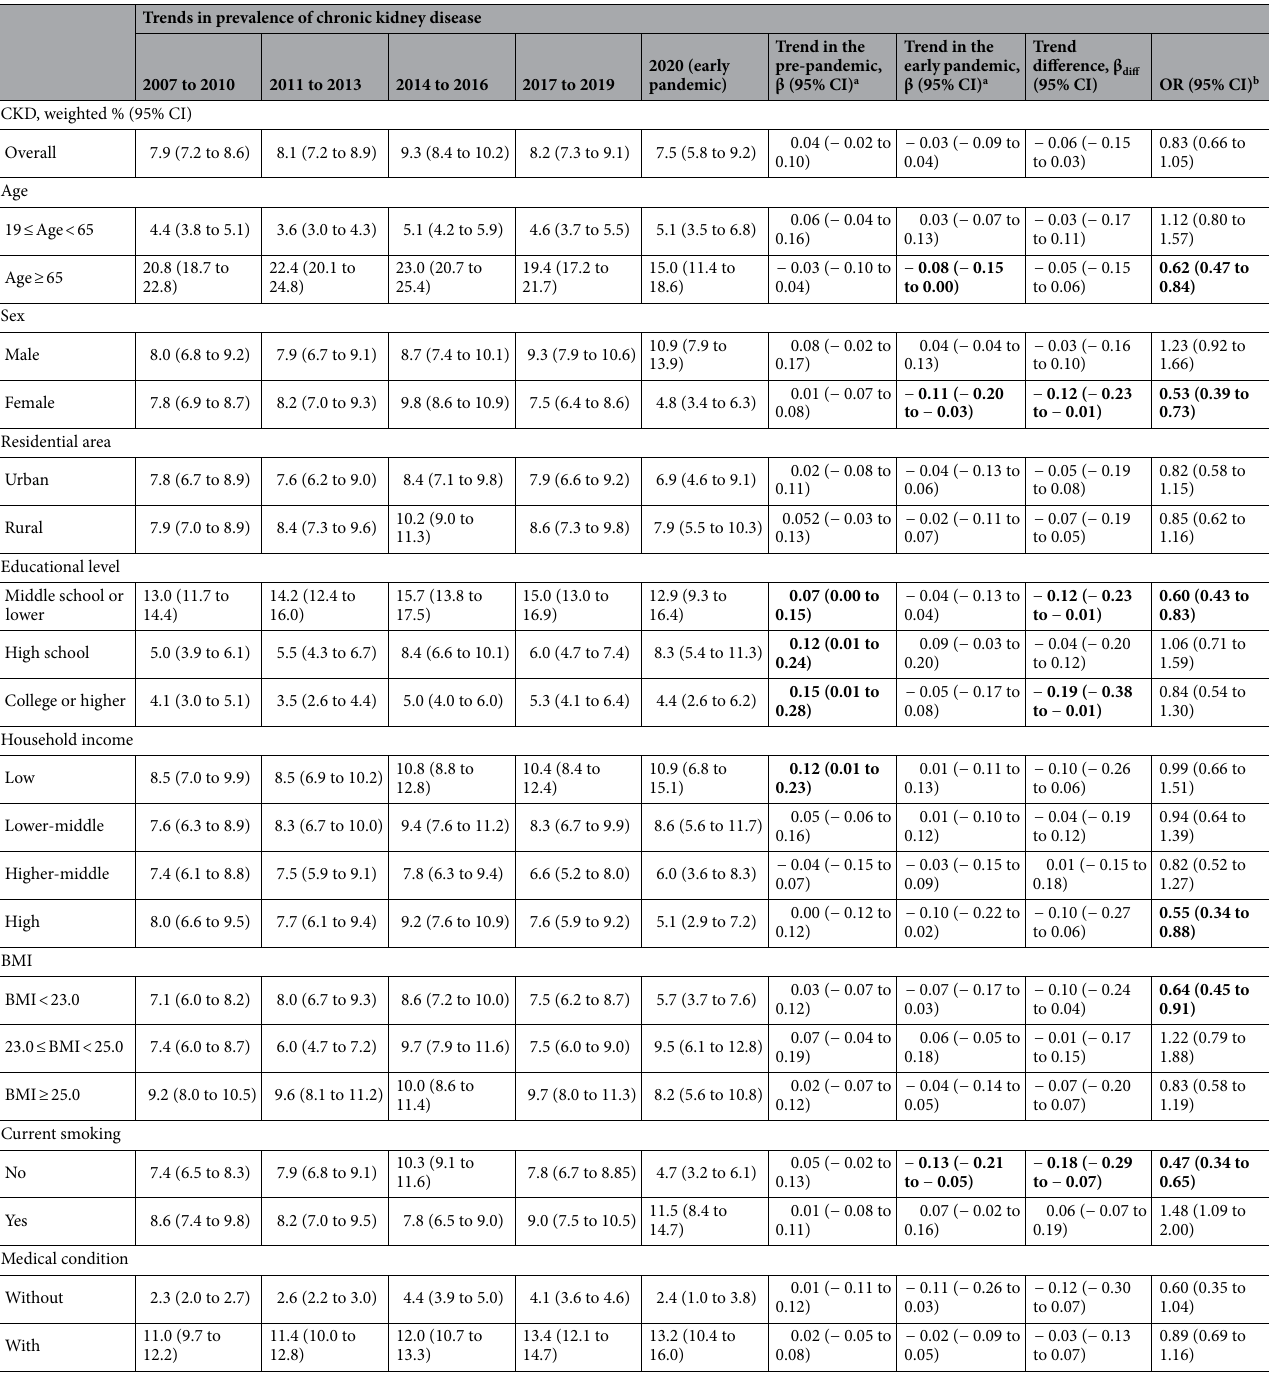
Table 4. Chronic kidney disease weighted prevalence and trend in adults who visited the outpatient clinic within 2 weeks from 2007–2020. BMI body mass index, CKD chronic kidney disease, CI confidence interval, KNHANES Korea National Health and Nutrition Examination Survey, OR odds ratio. a Estimated β was calculated to analyze the year cycle (2007–2010, 2011–2013, 2014–2016, 2017–2019, and 2020) as a continuous variable using a linear regression model. b Estimated OR was calculated to analyze the year cycle (2017–2019 versus 2020 [COVID-19 pandemic]) as a categorical variable using a logistic regression model. The numbers in bold indicate a significant difference ( p <